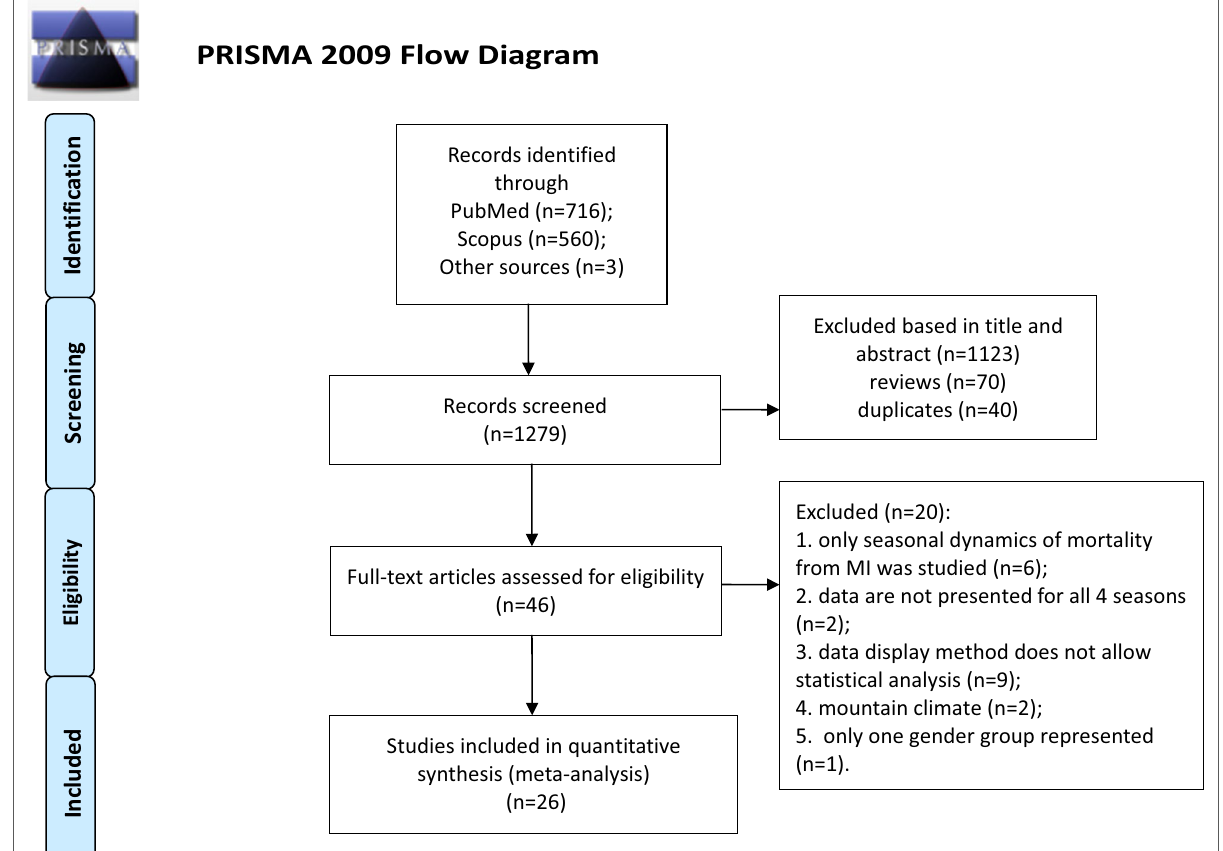
Fig. 1 Flow diagram according to the preferred reporting items for systematic reviews and meta-analysis guidelines (http:// prisma- state ment.